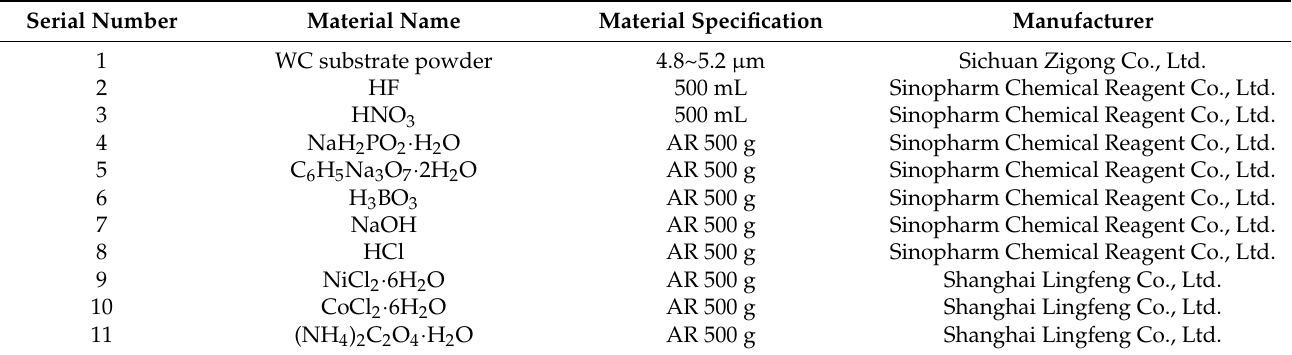
Table 1. Raw material parameter